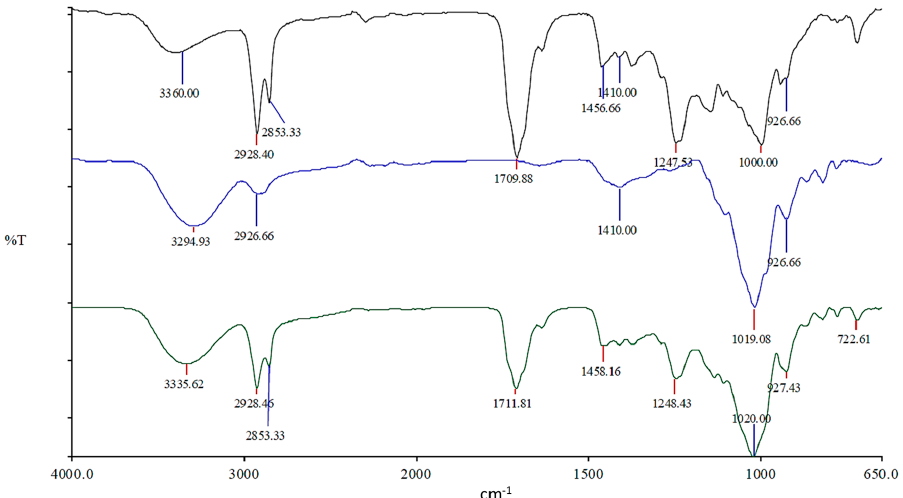
Figure 4. FTIR spectra for Biocare ® Bifidobacterium Probiotic powder (blue line–middle), 100% melt- extruded SSB ® 55 shellac (black line–top) and probiotic compounded with shellac at the highest loaded combined sample (50% w / w ) (green line–bottom).